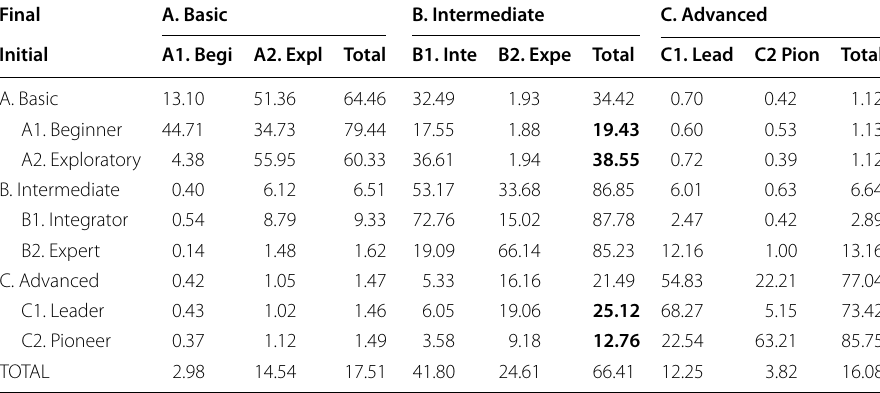
Highlighted in bold are the largest displacements found in this study, occurring from Basic to Intermediate levels, besides the displacement from Advanced to Intermediate